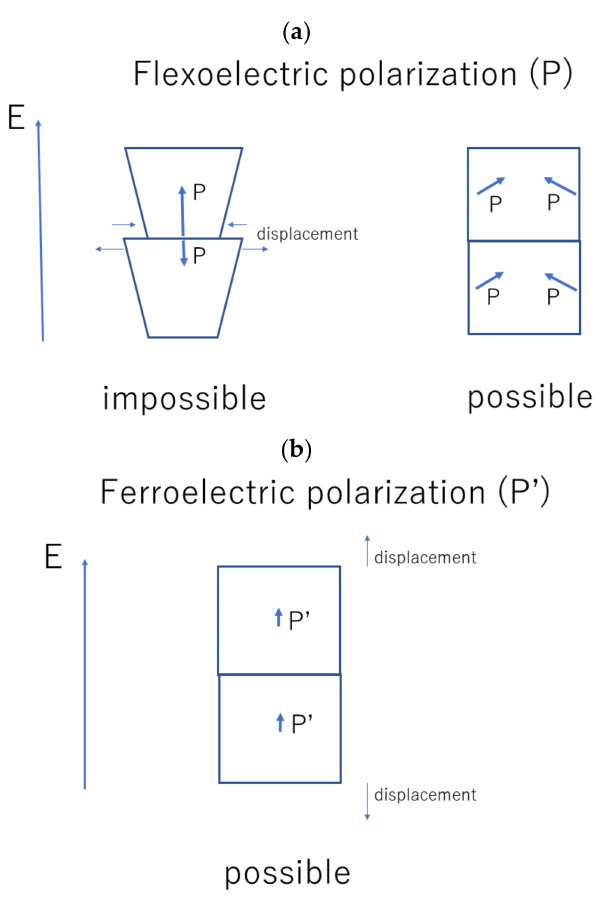
Figure 1. Flexo- ( a ) and ferro-electric ( b ) polarization under applied alternating electric field (E) for tightly joined BaTiO 3 nanocubes in an ordered